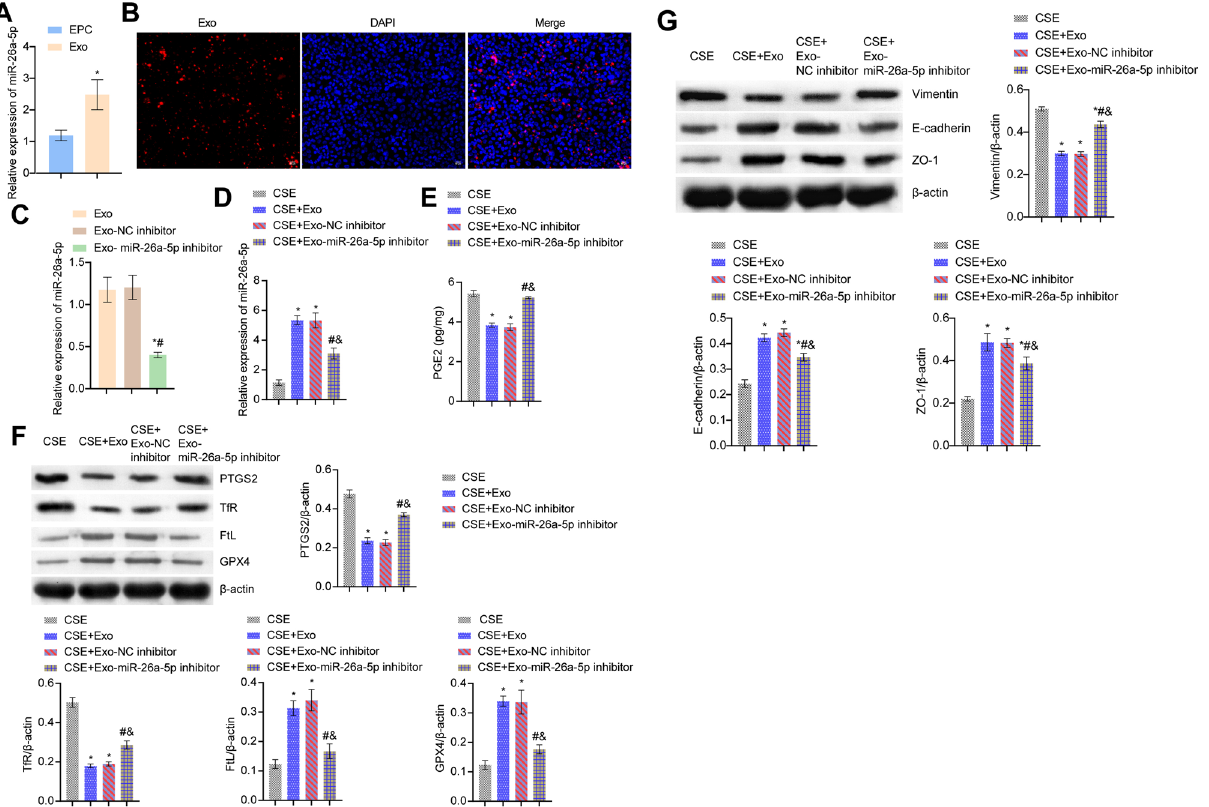
Figure 8. Exo-miR-26a-5p alleviated CSE-induced ferroptosis and EMT. ( A ) qRT-PCR verification of miR- 26a-5p expression. *P < 0.05 vs. EPC. ( B ) Exo uptake assay. ( C ) miR-26a-5p mRNA expression. *P < 0.05 vs. Exo, #P < 0.05 vs. Exo-NC inhibitor. ( D ) miR-26a-5p mRNA expression. ( E ) ELISA detection of PGE2 expression. ( F ) The expressions of PTGS2 and ferroptosis markers TfR, FtL, and GPX4 were detected by western blot. G. EMT markers Vimentin, E-cadherin, and ZO-1 protein expression of BECs. *P < 0.05 vs. CSE, #P < 0.05 vs. CSE + Exo, &P < 0.05 vs. CSE + Exo-NC inhibitor. The data were presented in the form of mean ± standard deviation. n =